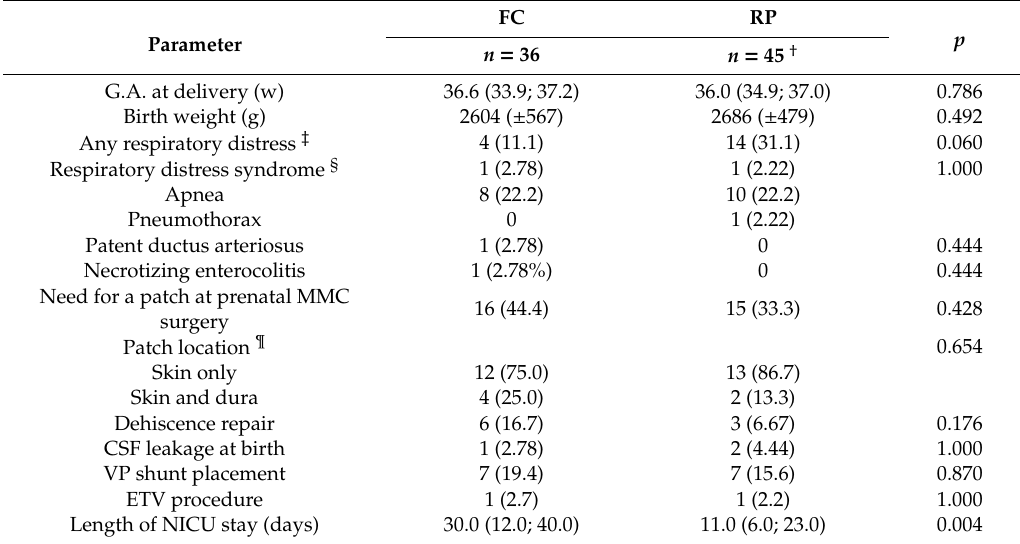
Table 3. Neonatal outcomes.